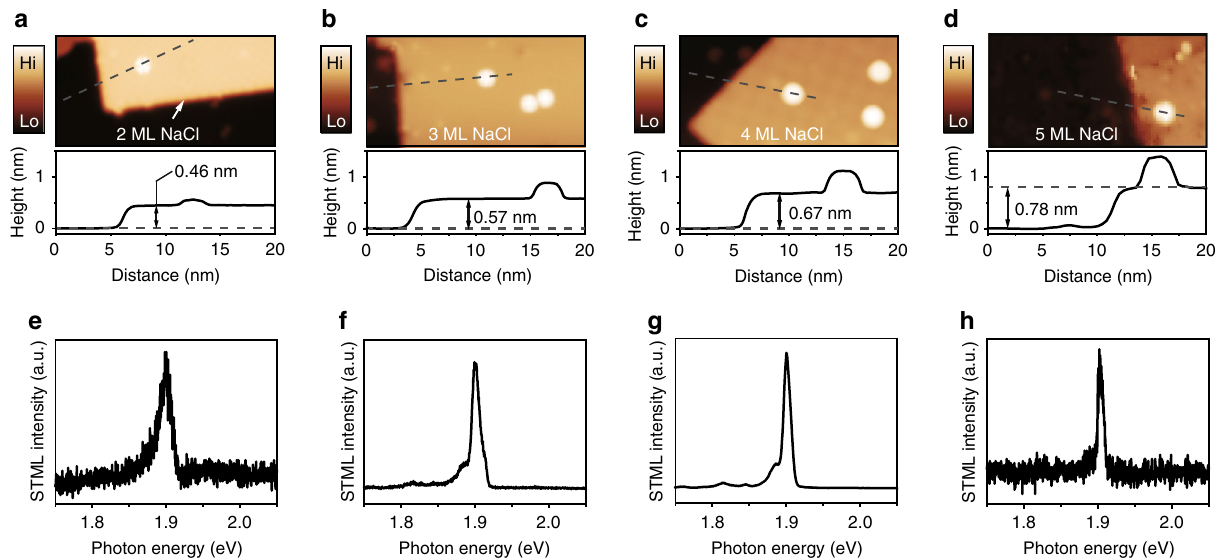
Fig. 2 Single-molecule electroluminescence. a – d STM images of single fl at-lying ZnPc molecules adsorbed on 2, 3, 4, and 5 ML thick NaCl islands, respectively (2.5 V, 2 pA, 30 × 15 nm 2 ). The number of MLs is veri fi ed by apparent thicknesses measured from corresponding height pro fi les (along dashed gray lines ) displayed underneath each image 40 . e – h Corresponding single-molecule electroluminescence spectra when the tip is positioned above the lobe of a ZnPc molecule on different NaCl thickness: 2 ML ( e , − 2.5 V, 200 pA, 60 s), 3 ML ( f , − 2.5 V, 100 pA, 60 s), 4 ML ( g , − 2.5 V, 100 pA, 20 s), and 5 ML ( h , − 2.5 V, 2 pA, 5